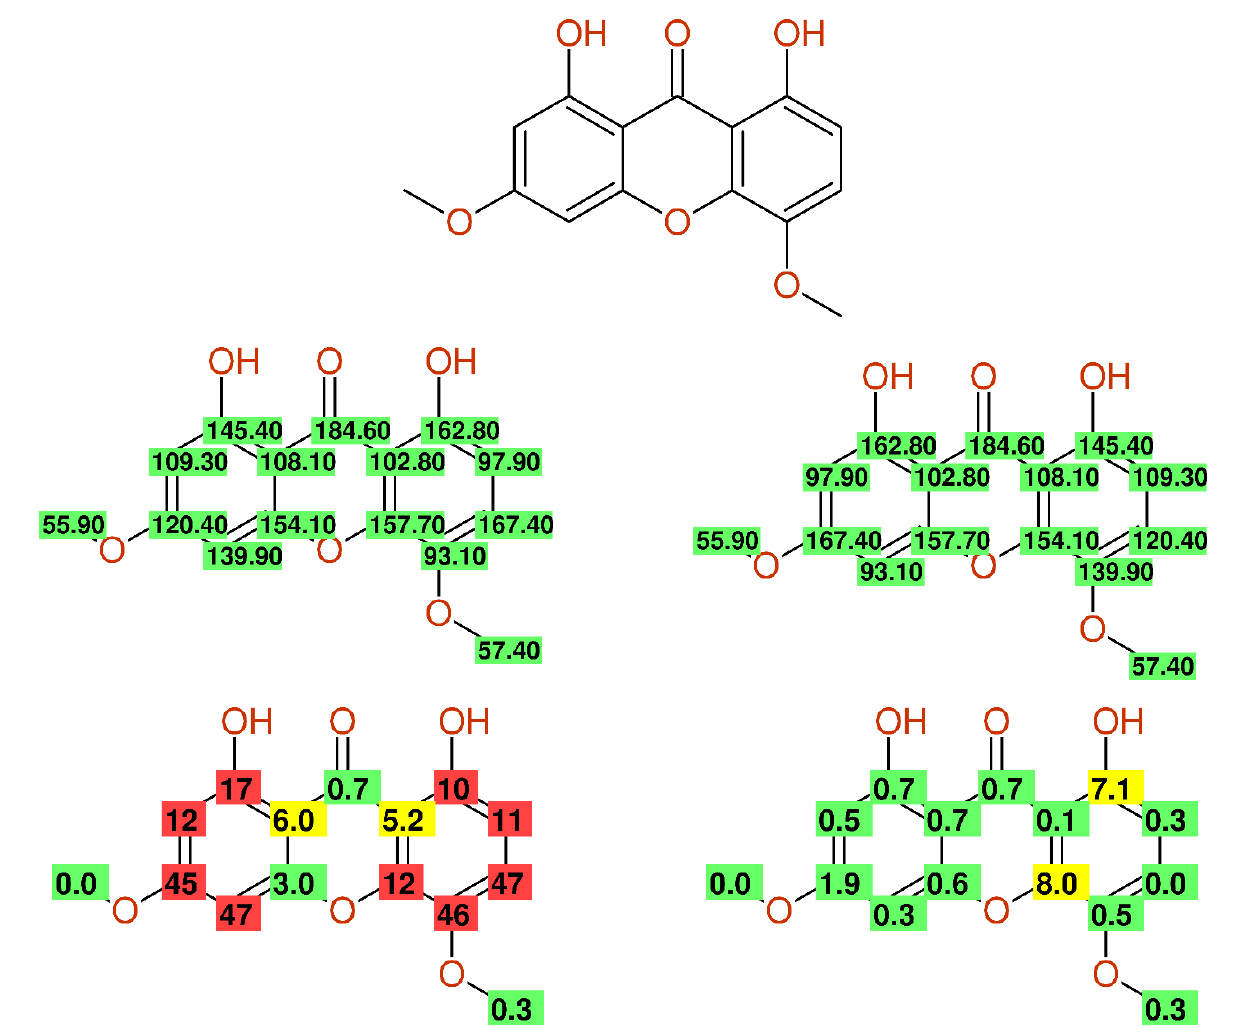
Figure 7. 13 C-NMR data of compound 1 from [50] as published ( left ) and after correction ( right ), together with the differences between the experimental and predicted chemical shift values. The deviations remaining after the first step of correction (7.1/8.0 ppm) point out an additional assignment problem.